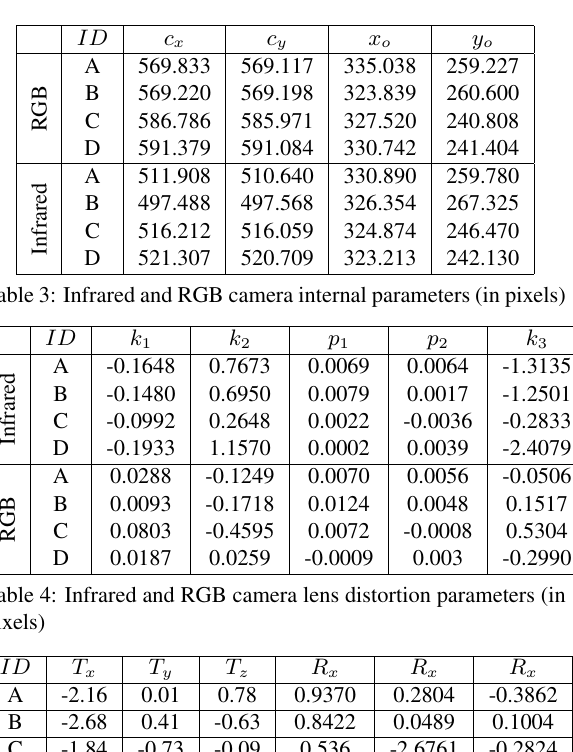
Figure 9: Variation of the trajectories along the Y axis